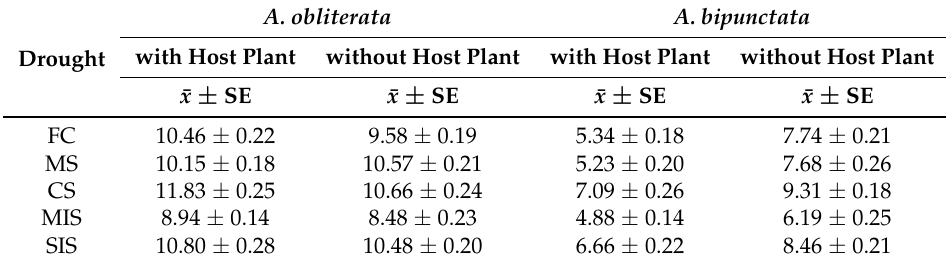
Table 2. Mean consumption rates by 1st instar coccinellid larvae of E. abietinum raised under drought to fluctuate from 70% to 30% field capacity; SIS = allowed to fluctuate from field capacity to 20% field